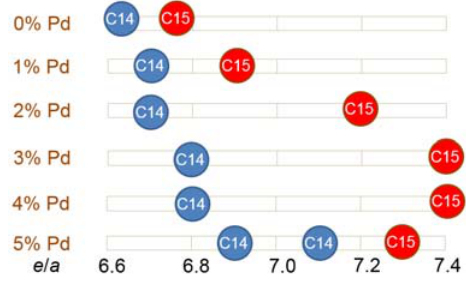
Figure 9. Plots of the e / a values for the C14 and C15 phases. A shift in the C14/C15 threshold to a higher e / a value with increasing Pd ‐ content in design is observed.